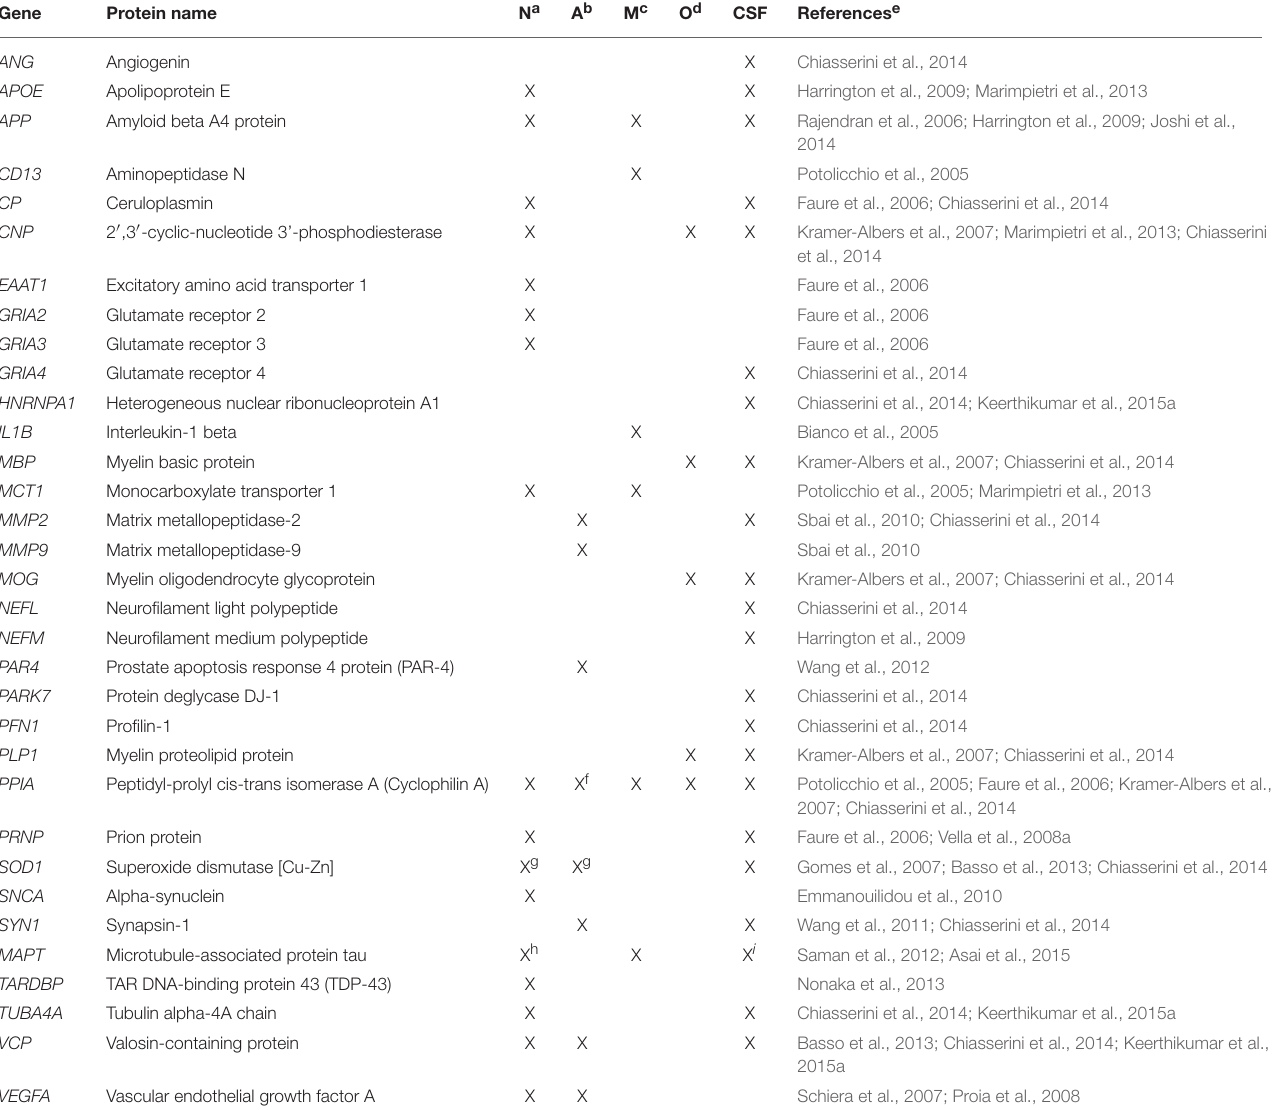
TABLE 3 | A selection of proteins identified in EVs isolated from cultured cell media (neurons, astrocytes, microglia, oligodendrocytes) and CSF that are relevant for the CNS under physiological and pathological